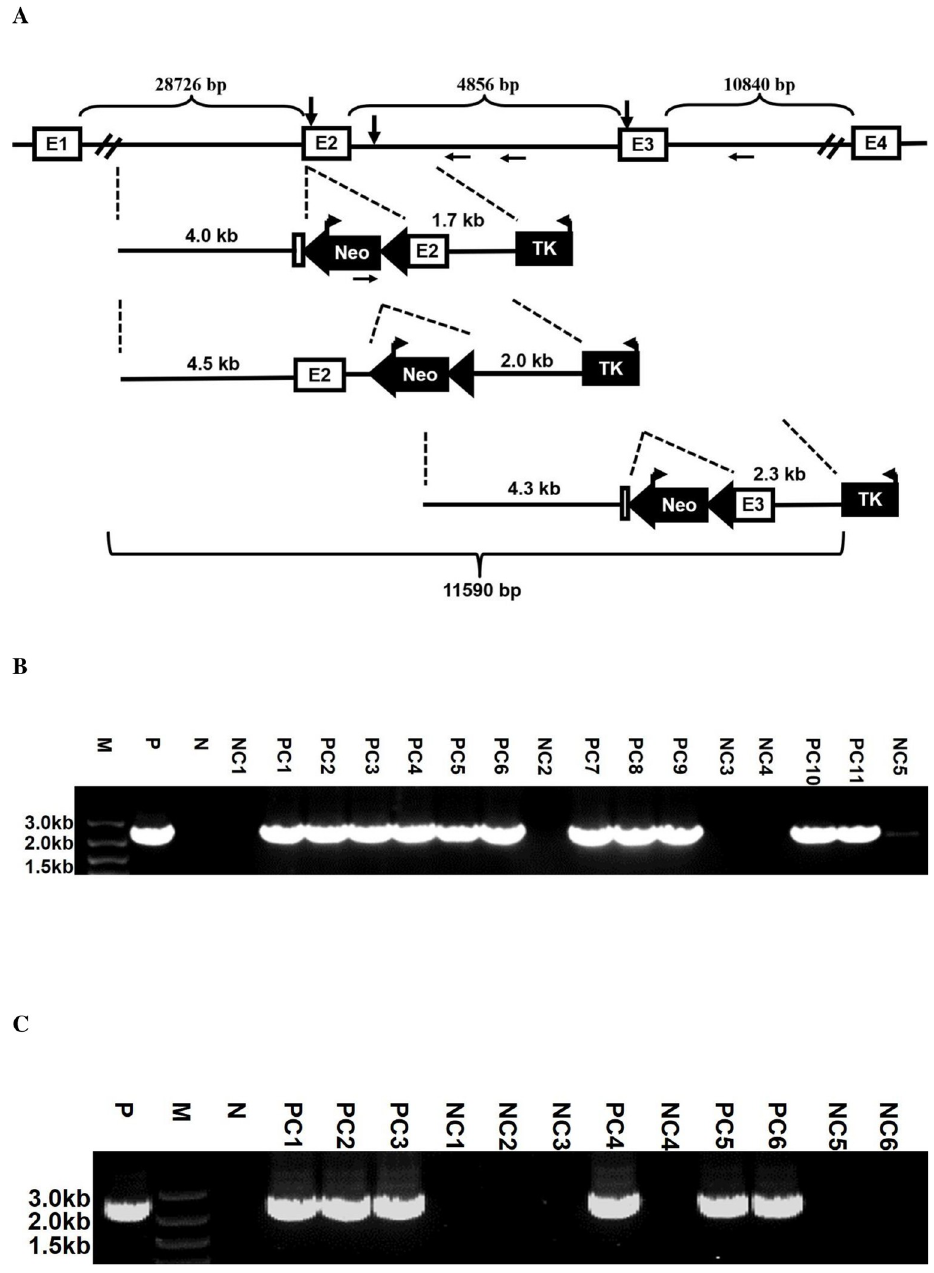
Fig 1. Gene targeting at various sites of the mouse Myh9 locus. (A) Diagram of the constructs targeting to different sites of the Myh9 gene locus. Shown are part of the Myh9 gene locus including exons1-4, the distance between them, the down arrows representing the targeted insertion of Neomycin (upper), the constructs targeting to distinct sites of the Myh9 gene locus and the length of the 5’ and 3’ arms of these constructs (middle), as well as the whole sequence region used for the generation of these constructs (lower). The HR efficiency of these targeting constructs is summarized in Table 3. The average percentage of HR efficiency is derived from two repeats. (B) Representative gel image of PCR identification of the GT recombinants at the Myh9 gene exon2 site. (C) Representative gel image of PCR identification of the GT recombinants at the Myh9 gene exon3 site. For representative gel image of PCR identification of the GT recombinants at the Myh9 intron2 site, please see reference [31]. M: DNA Marker; P: Positive control; N: Negative control; PC: positive clone; NC: negative clone.